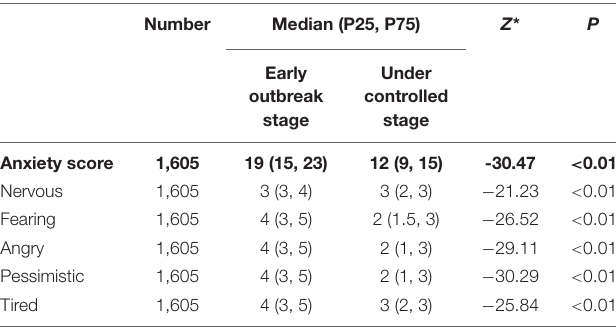
TABLE 3A | The level of anxiety of participants from early outbreak stage to under controlled stage of COVID-19 in China, 2020. Number Median (P25, P75) Z * P